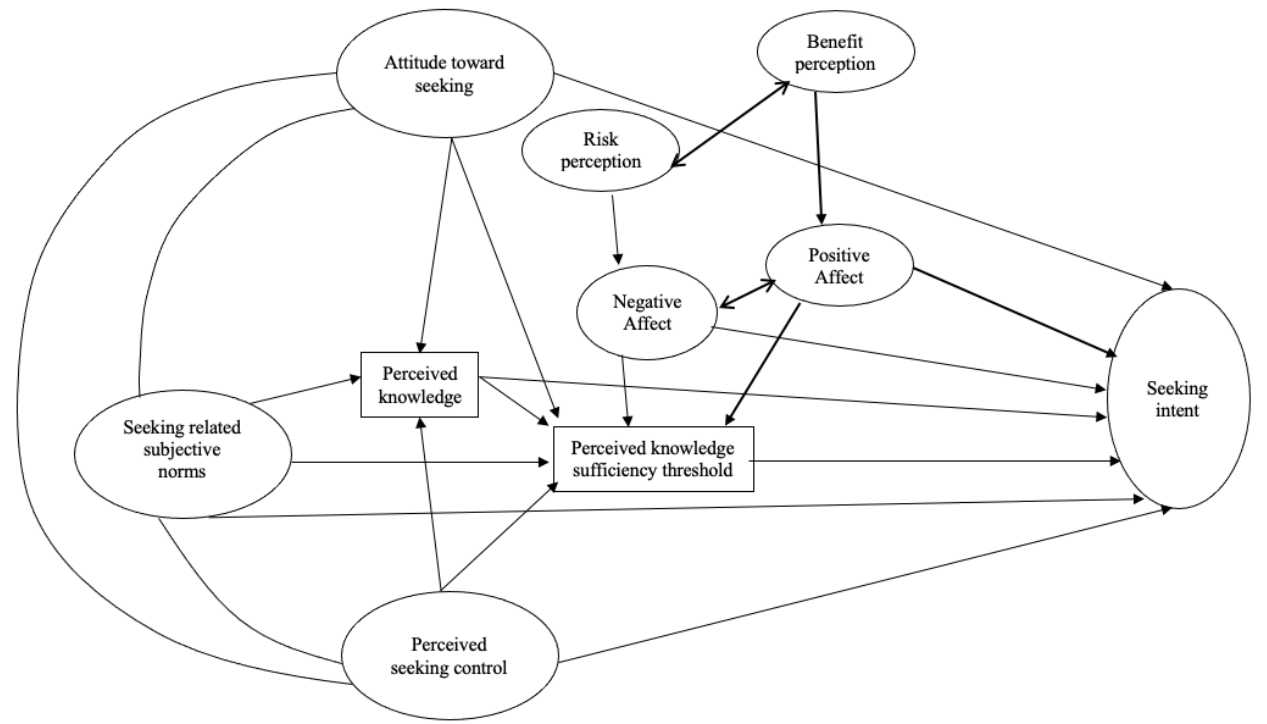
Figure 1. Demonstrations of the planned risk information seeking model with benefit perception and positive affect.